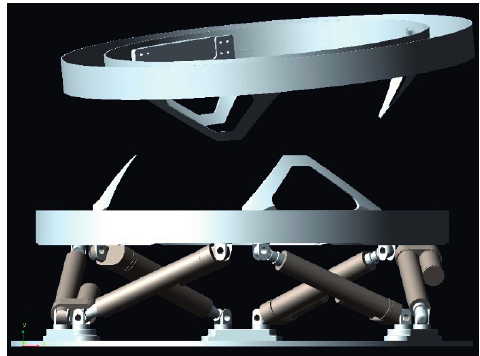
Figure 7. The LIDM model built in